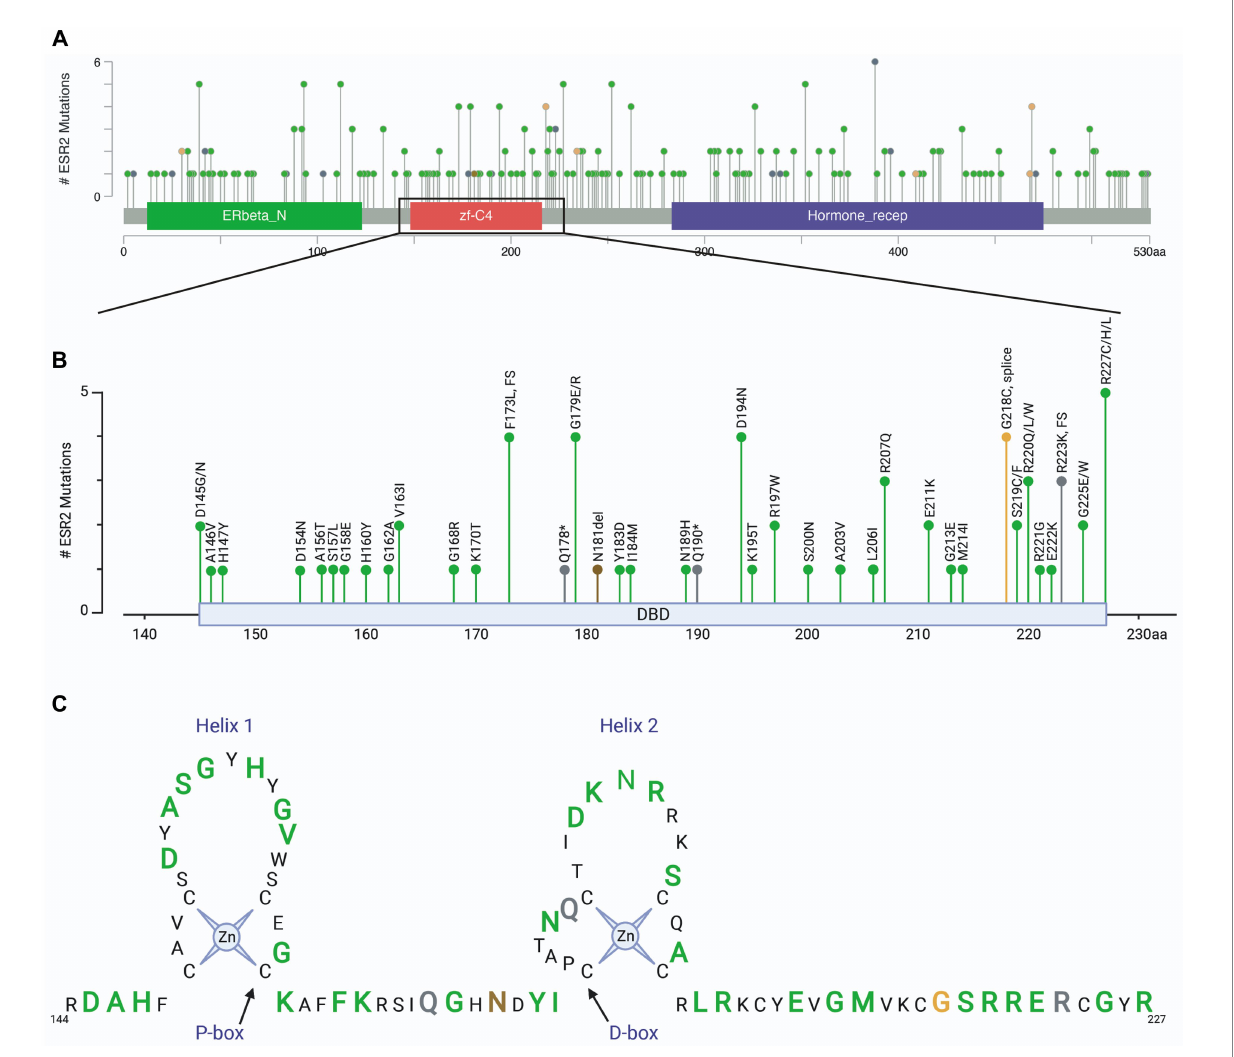
FIGURE 5 ESR2 mutations identified in clinical specimens. (A) Screen shot of all ESR2 mutations identified in 342 cBioPortal.org studies representing 165,871 patients. A total of 417 mutations were identified across 254 independent patient samples. (B) Inset highlighting 110 mutations identified specifically in the DNA binding domain. (C) Schematic highlighting DNA binding domain mutations where green represents missense mutations, grey represents truncations, brown represents inframe deletions/insertions and orange represents splice mutations. Amino acids depicted by smaller black text were not mutated in any of the samples represented in the 165,871 patients included in this